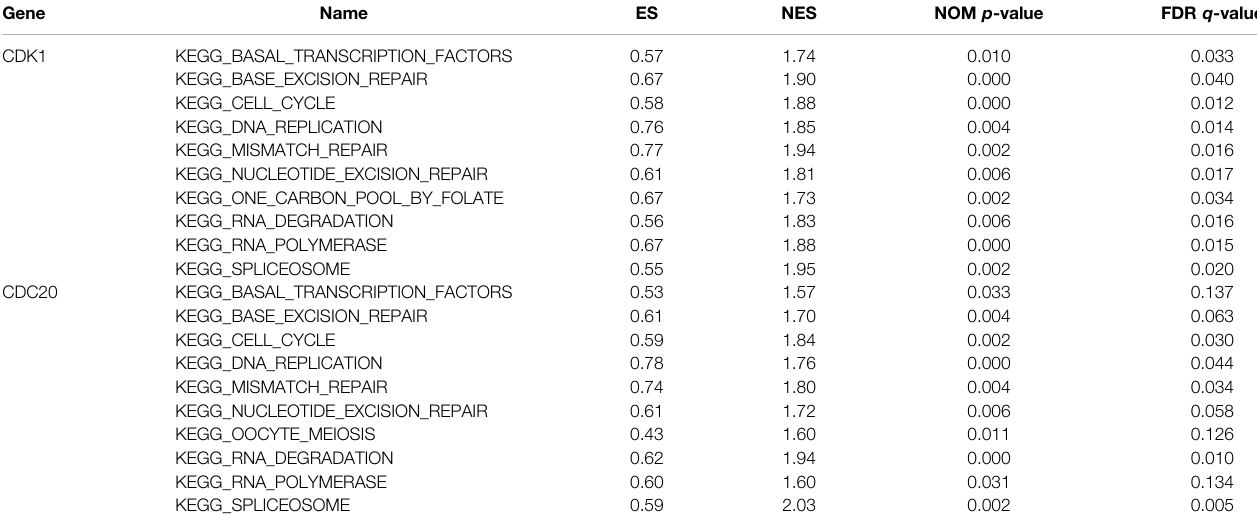
TABLE 4 | Relative pathways associated with the expression of CDK1 and CDC20 using GSEA.